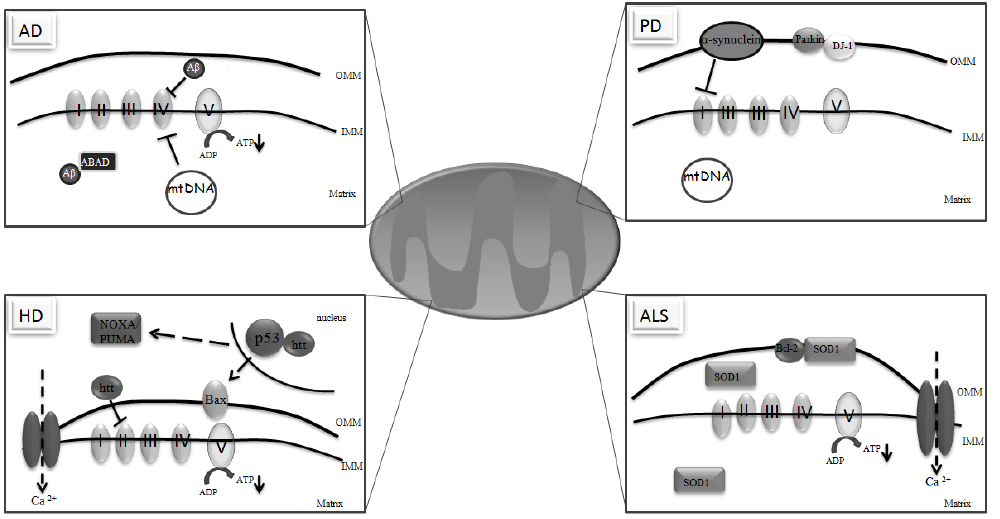
Figure 1. Mitochondrial dysfunction in neurodegeneration. In Alzheimer´s disease (AD), A β accumulates in mitochondria and binds to A β -binding alcohol dehydrogenase (ABAD) inhibiting complex IV, potentiating reactive oxygen species (ROS) formation and decreasing ATP production. AD pathology can also be influenced by mutations in the mtDNA, since mtDNA from AD subjects have a higher rate of mutations. In Parkinson´s Disease (PD), complex I activity is impaired contributing to the formation of high levels of ROS. Many of the genes involved in PD are also associated with mitochondrial dysfunction. α -synuclein overexpression potentiates mitochondrial impairment and oxidative stress. Parkin associates with the outer mitochondrial membrane (OMM) protecting mitochondria against ROS release and caspase activation. DJ-1 is an integral protein that participates in the oxidative stress response and protects against the loss of dopaminergic neurons. In PD, the level of mtDNA mutations is also associated with respiratory chain deficiencies. In Huntington’s disease (HD), mutant huntingtin (htt) compromises complex II activity, ATP production and the calcium (Ca 2+ ) buffering capacity. htt also affects mitochondrial function through its interaction with p53 in the nucleus leading to upregulation of BAX and PUMA, two pro-apoptotic proteins. In amyotrophic lateral sclerosis (ALS), mutant Cu/Zn superoxide dismutase (SOD1) that is localized in the outer mitochondrial membrane (OMM), intermembrane space (IMM) and mitochondrial matrix, impairs mitochondrial respiration and ATP synthesis as well as the mitochondrial Ca 2+ loading capacity. Mutant SOD1 binds to Bcl-2 on the OMM blocking its anti-apoptotic